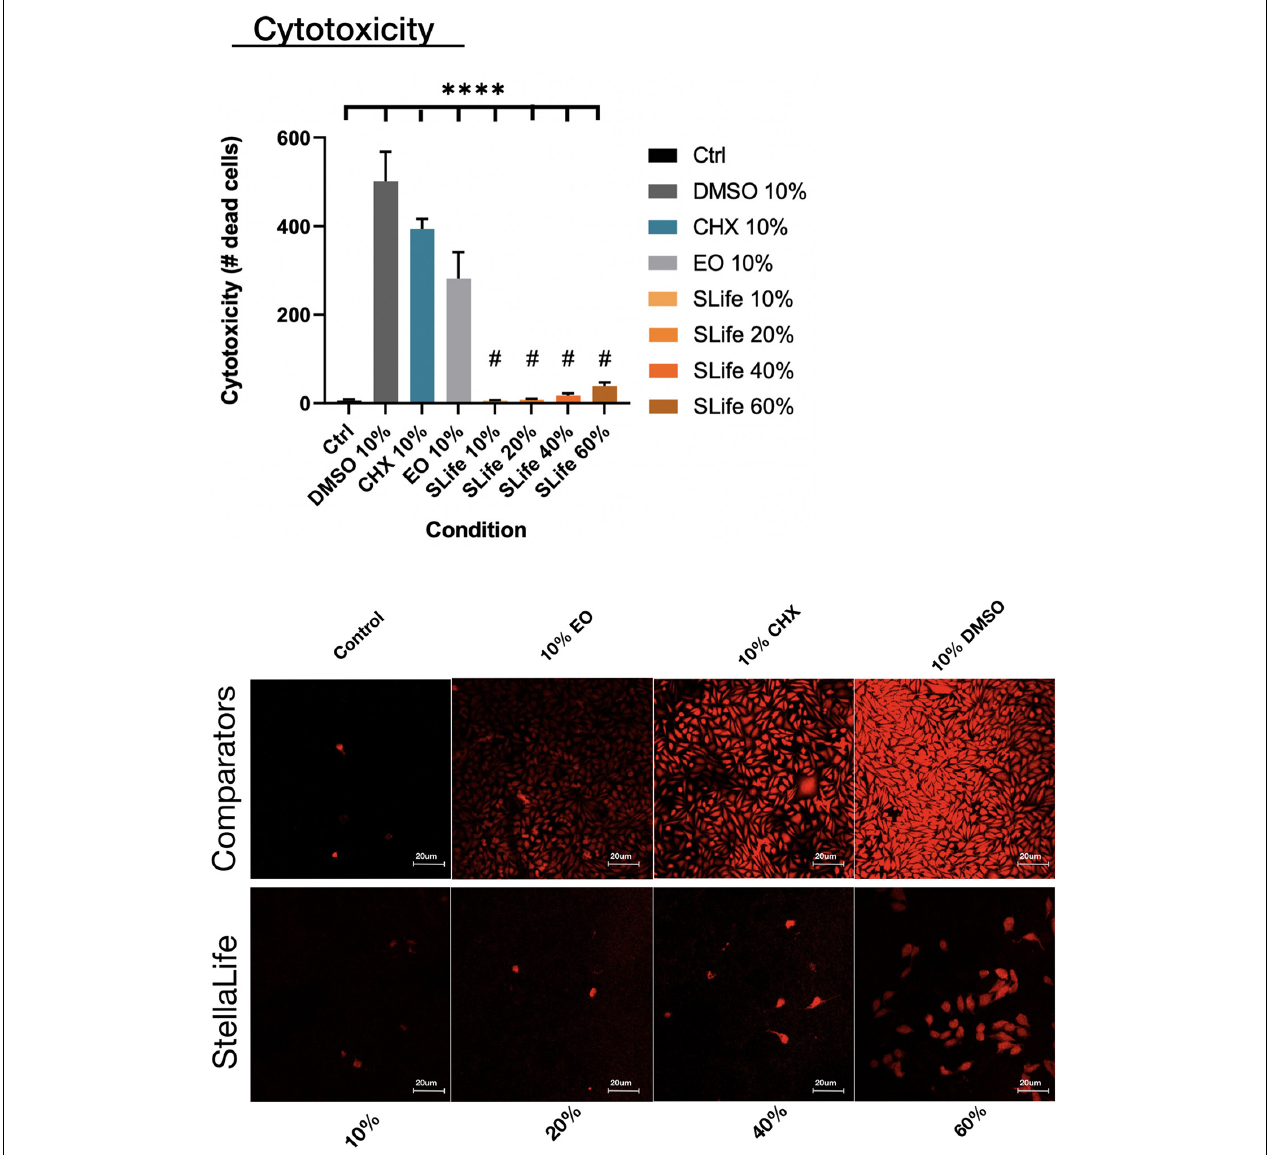
FIGURE 1 | The number of dead cells taking up Zombie red dye were counted after 5 min of incubation with either of the oral rinses. Fluorescent images demonstrated limited toxicity of SLife even up to 40% v/v concentrations as compared to the pronounced cytotoxicity of active comparators at 10% v/v dilutions. ****Designates highly significant difference ( p < 0 . 001) to control. # Designates statistically significant difference ( p < 0 . 05) to active group comparators.